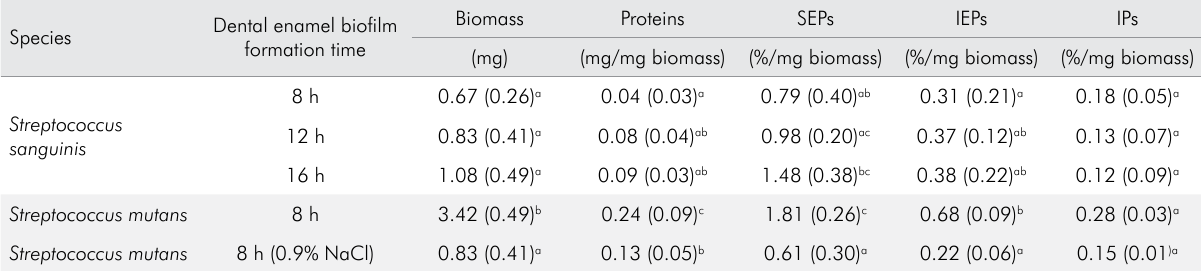
Table 1. Biofilm properties after exposure of dental enamel to different biofilm formation times in presence of sucrose for both bacteria and NaCl in S. mutans . Mean (SD), n =